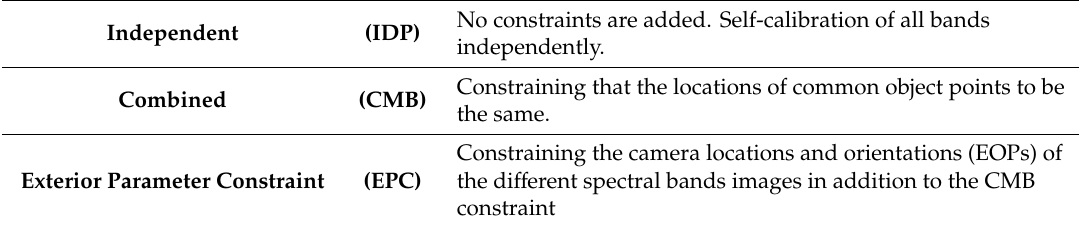
Table 1. Overview of the used adjustment types (left column), the abbreviation used in this paper (centre column) and a brief explanation (right column). No constraints are added. Self-calibration of all bands Independent (IDP) independently. Constraining that the locations of common object points to be Combined (CMB) the same. Constraining the camera locations and orientations (EOPs) of Exterior Parameter Constraint (EPC) the di ff erent spectral bands images in addition to the CMB